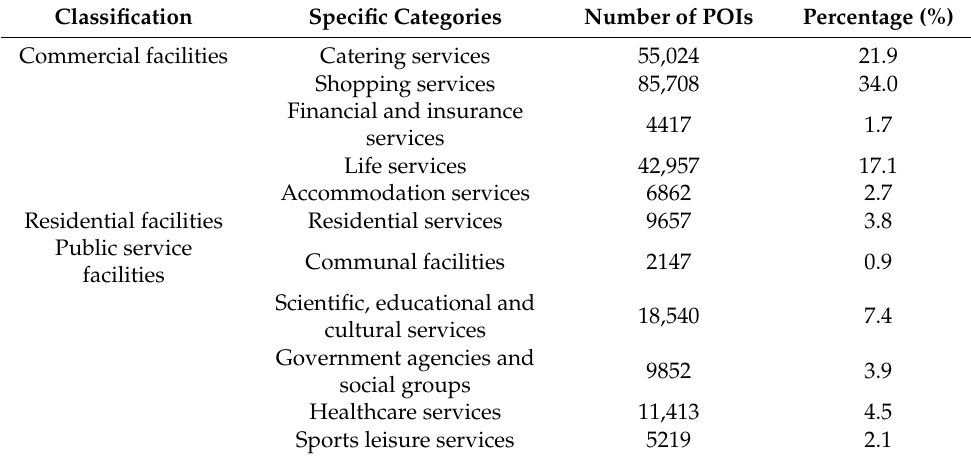
Table 1. Type and quantity of POI in the main urban area of